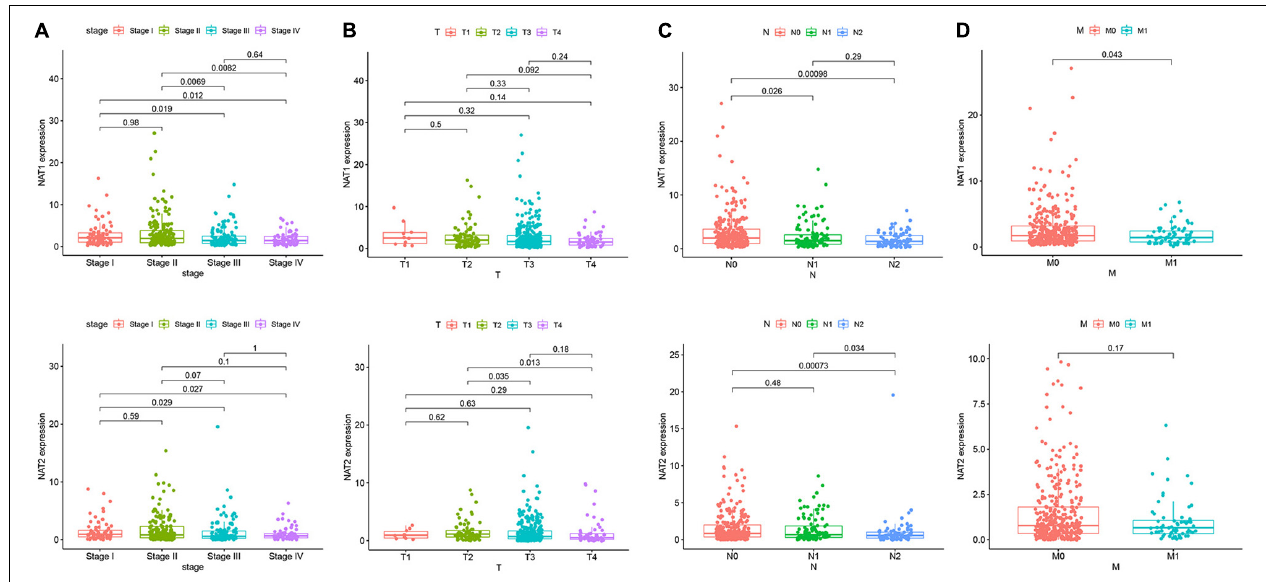
FIGURE 10 | NAT1 and NAT2 expression in subgroups of patients with COAD, stratified based on AJCC TNM stage. Wilcoxon rank sum tests were performed to compare the difference of NAT1 and NAT2 expression among different subgroups of clinicopathological variables. (A) Boxplot showing relative expression of NAT1 and NAT2 in COAD patients in stage 1, 2, 3, or 4. (B) Boxplot showing relative expression of NAT1 and NAT2 in COAD patients in T1, 2, 3, or 4. (C) Boxplot showing relative expression of NAT1 and NAT2 in COAD patients in N0, 1, or 2. (D) Boxplot showing relative expression of NAT1 and NAT2 in COAD patients in M0, or 1. The central mark is the median; the edges of the box are the 25th and 75th